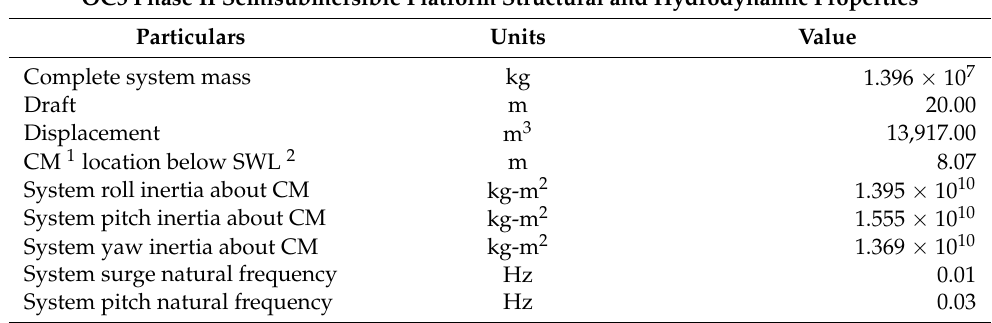
Table 1. Structural and hydrodynamic properties of the OC5 semisubmersible platform